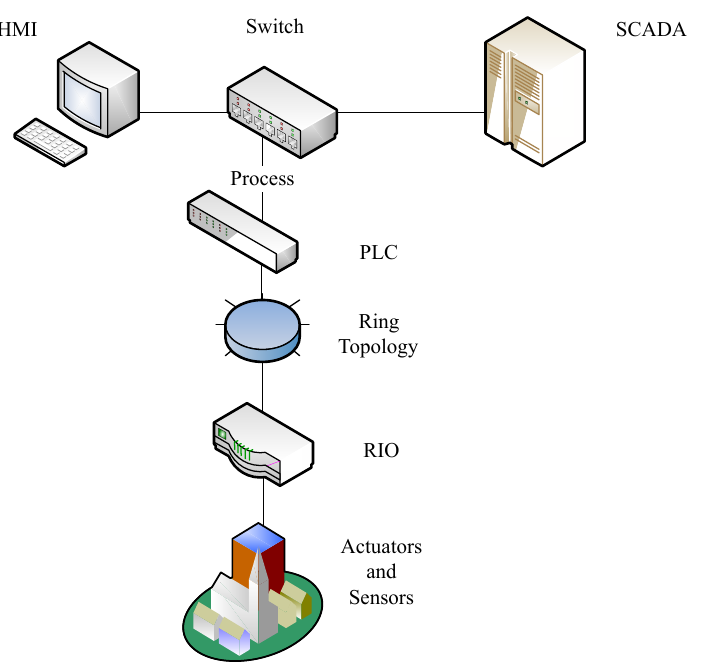
Figure 4. SWaT Industrial Control Network.